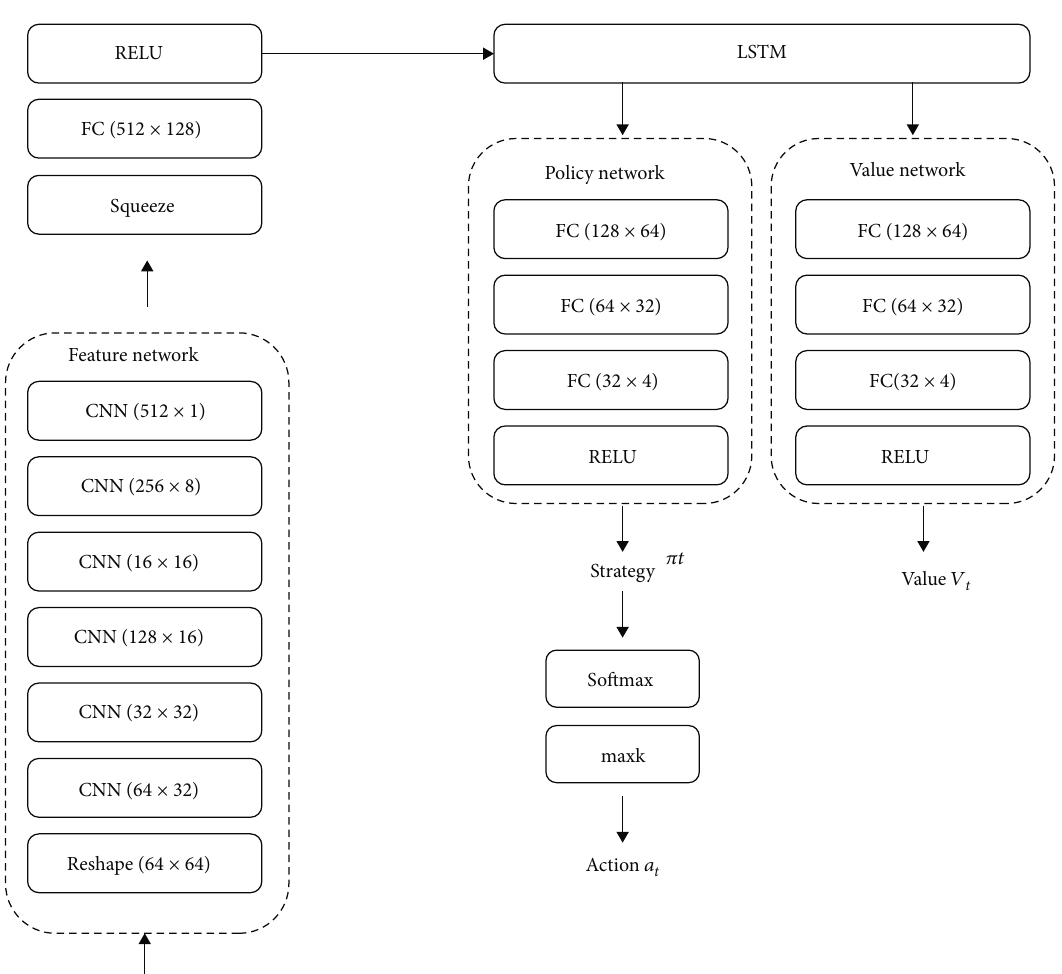
Figure 4: Schematic diagram of network structure of urban land network generation based on strategy